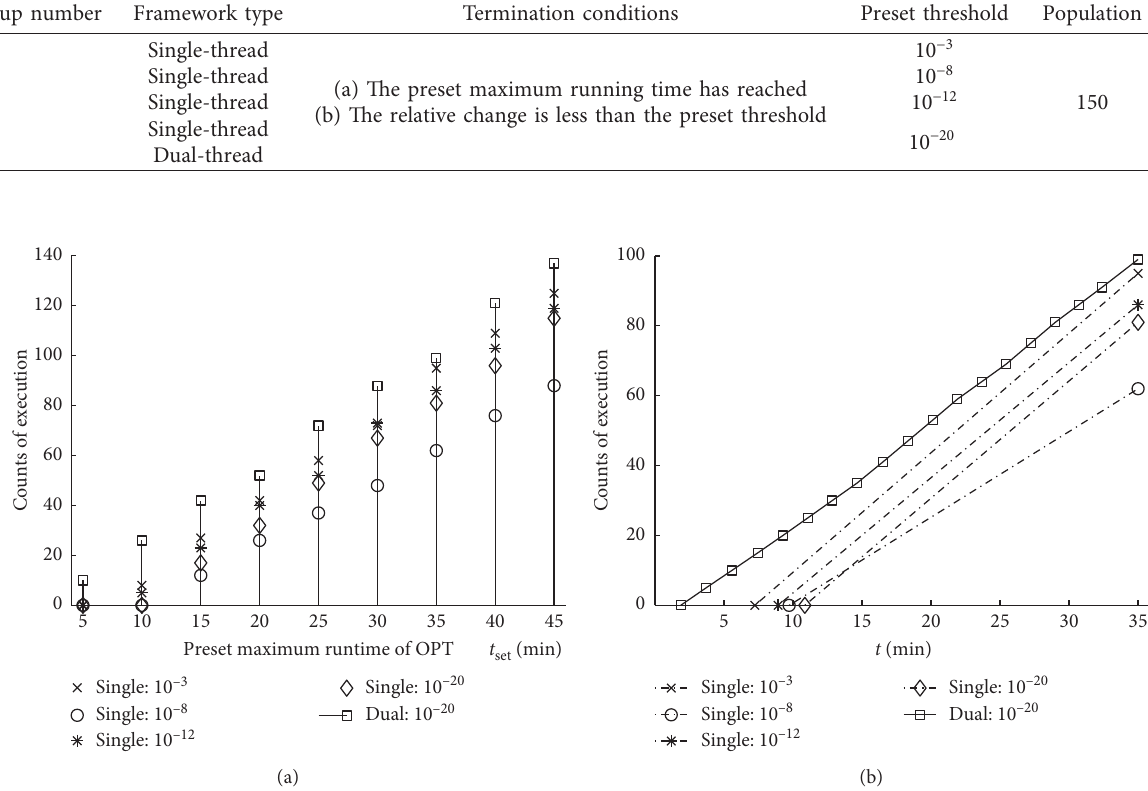
Figure 6: Comparison between single/dual-thread framework. (a) Stem plot of execution counts with respect to different preset maximum runtime of OPT with 9 rounds. (b) Plot of execution counts with respect to time for the single round with preset maximum runtime t set � 35